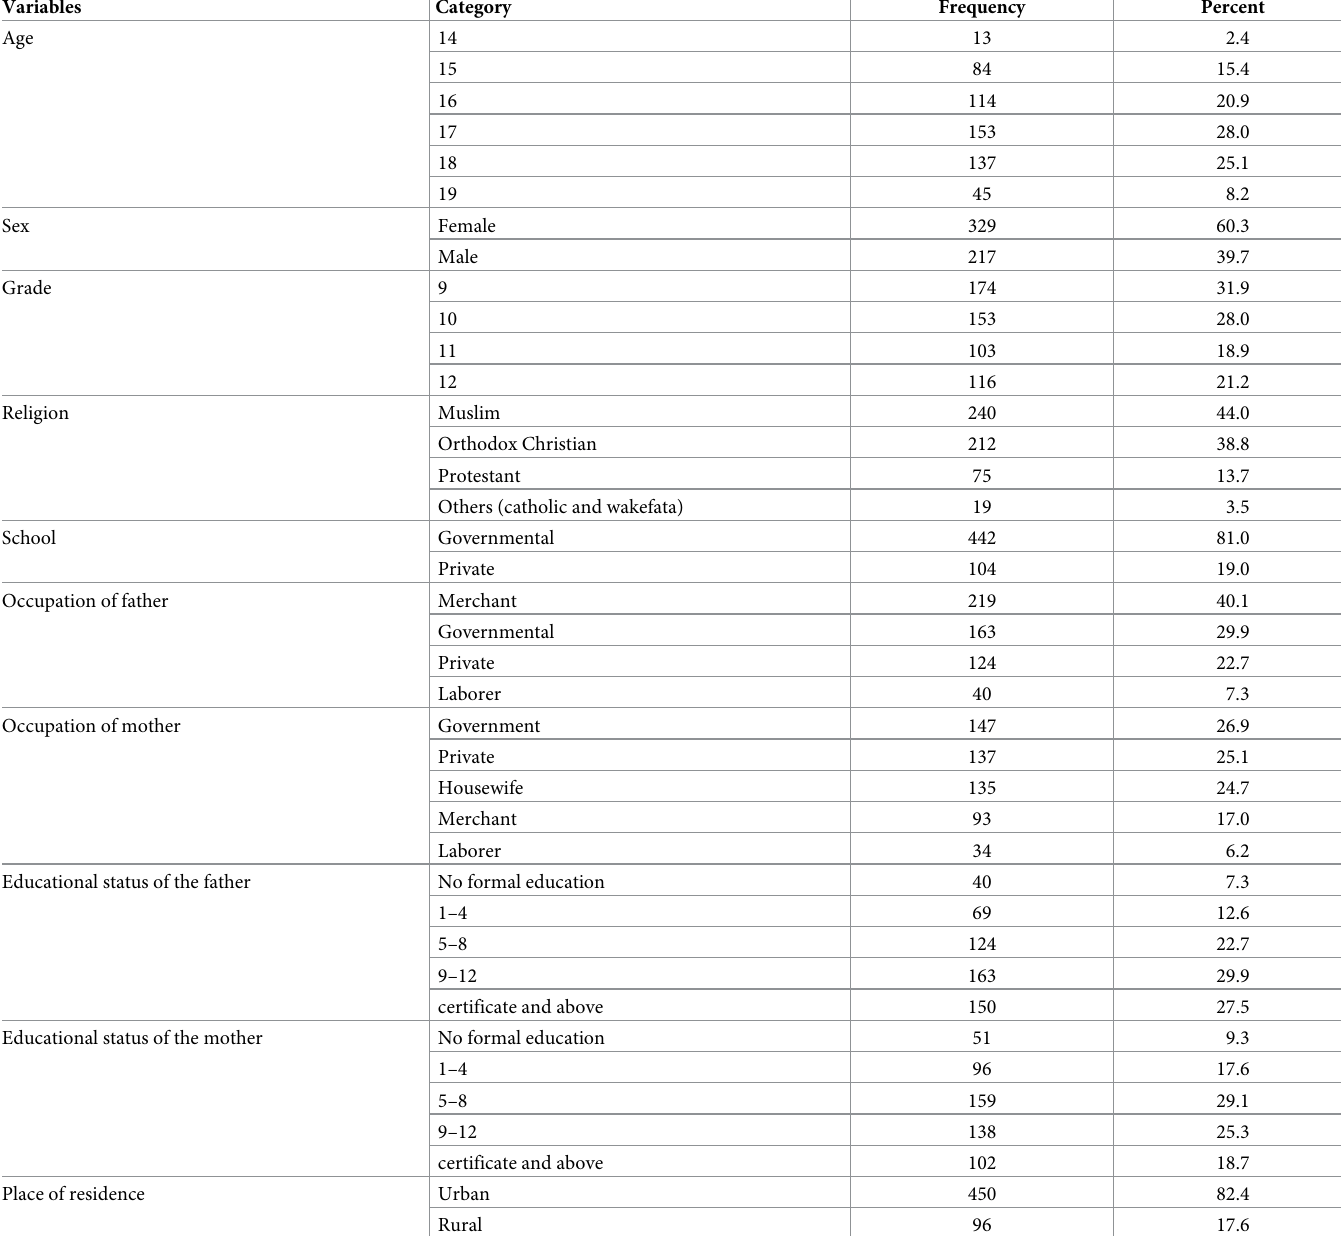
Table 1. Sociodemographic characteristics of school-going adolescents in Jimma town, Southwest Ethiopia (n = 546).